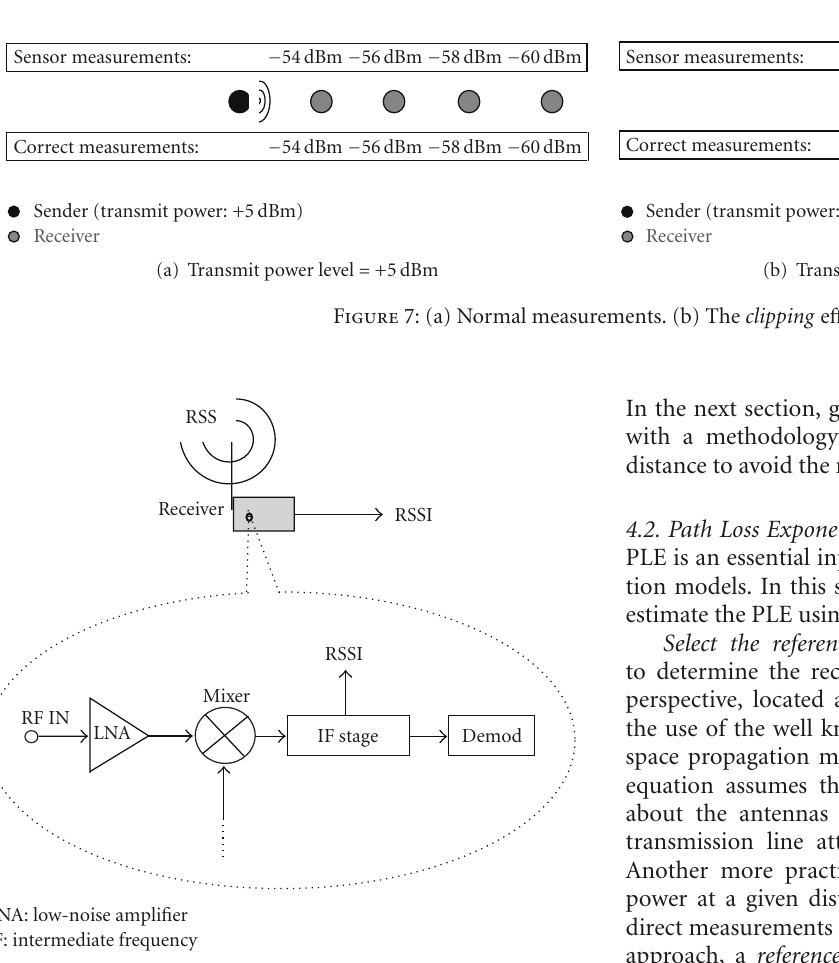
Figure 8: Typical receiver circuitry of a sensor